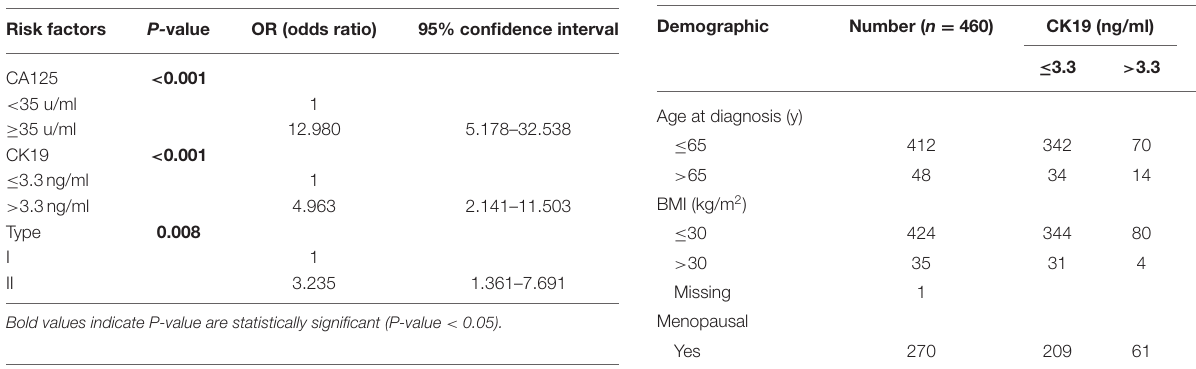
TABLE 4 | Correlation between pre-treatment CK19 > 3.3ng/ml and clinical characteristics.